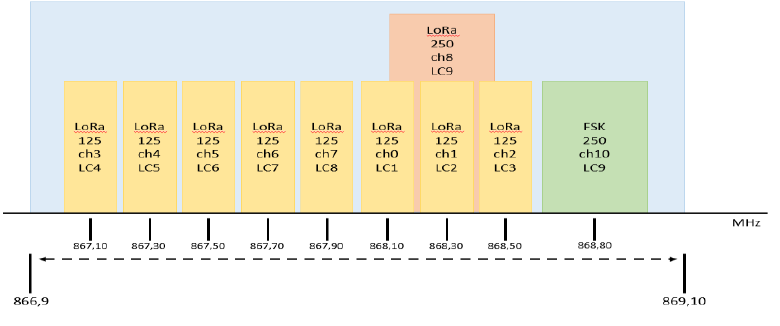
Figure 2. Description of LoRaWAN channels.